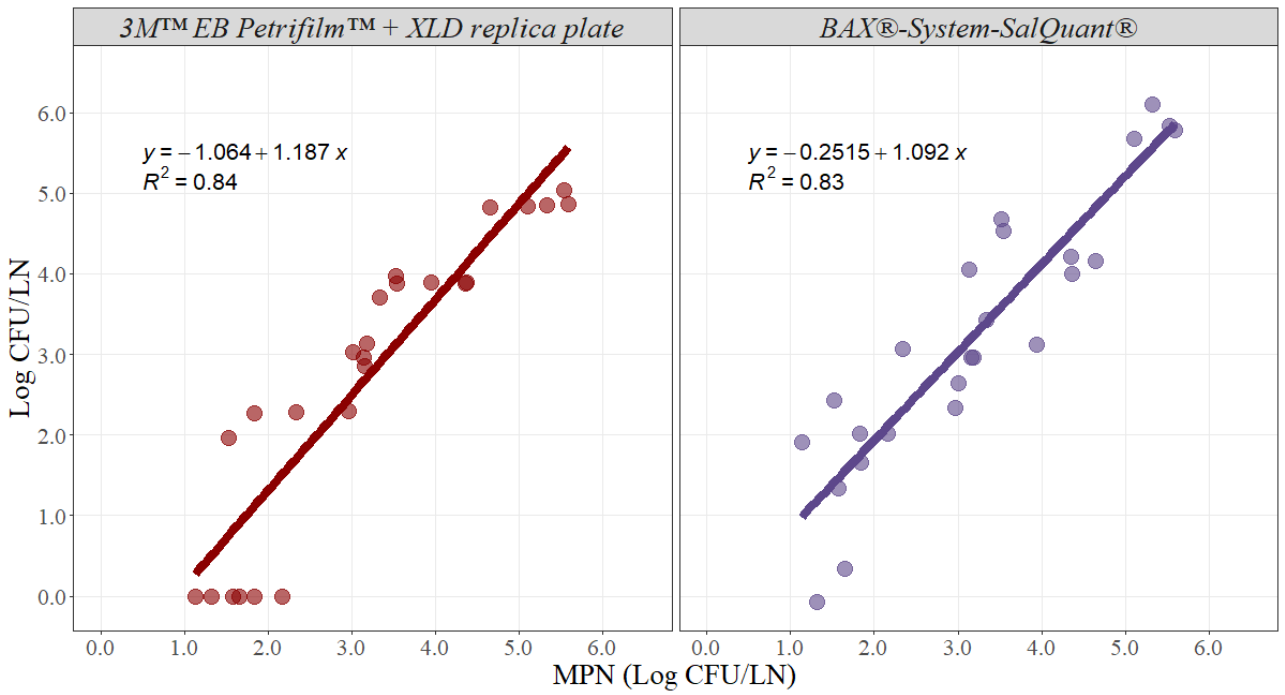
Figure 4. Graphical representation of the linear correlation comparing EB Petrifilm + XLD replica plate and BAX ® -System-SalQuant ® versus MPN for quantification of Salmonella in beef lymph nodes (n = 25 per method). The dots represent the actual data points.